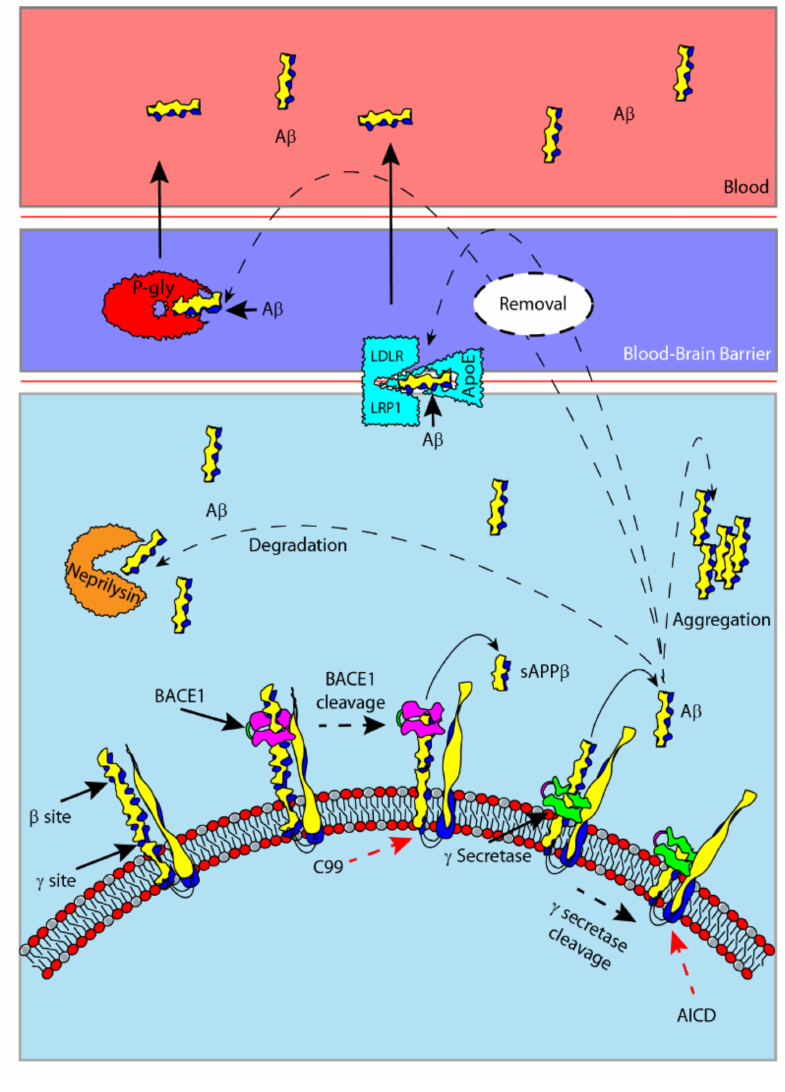
Figure 1. Schematic representation of amyloid- β (A β ) generation from amyloid precursor protein (APP) processing by secretases on cell membranes. β -secretase cuts APP on the β -site, producing a soluble fragment (sAPP β ); while γ -secretase cuts on the γ -site, generating an intracellular fragment (AICD) and A β that is released. A β is degraded in the perivascular space by neprilysin, or inside endothelial cells and neurons. The transporters low-density lipoprotein receptor (LDLR) and LDLR-related protein 1 (LRP1) (after A β –apolipoprotein E (ApoE) complex binding) and P-glycoprotein allow A β to cross the blood–brain barrier to the blood, contributing to the increase of its plasmatic concentration. The impairment of A β clearance causes its aggregation in the perivascular